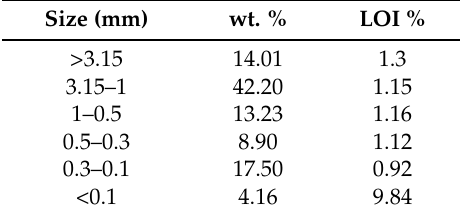
Table 2. Bottom ash particle size distribution and LOI.